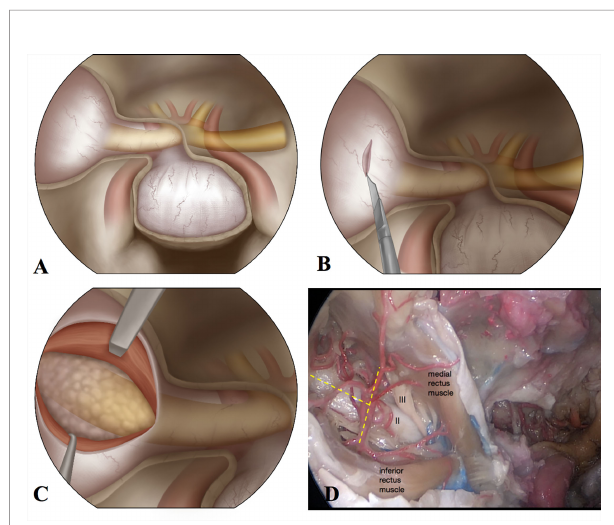
FIGURE 1 | The illustration of surgical steps and anatomic dissection of the orbit from an endoscopic endonasal view. (A) After opening the sella fl oor, lamina papyracea, and optic canal, right orbit is exposed. (B) The periorbita is cut open with a blade. (C) Retracting the medial rectus muscle and inferior rectus muscle to expose the intraconal lesion. (D) The anatomic dissection of the orbit from the endoscopic endonasal approach. The optic nerve, oculomotor nerve, and branches of ophthalmic artery are